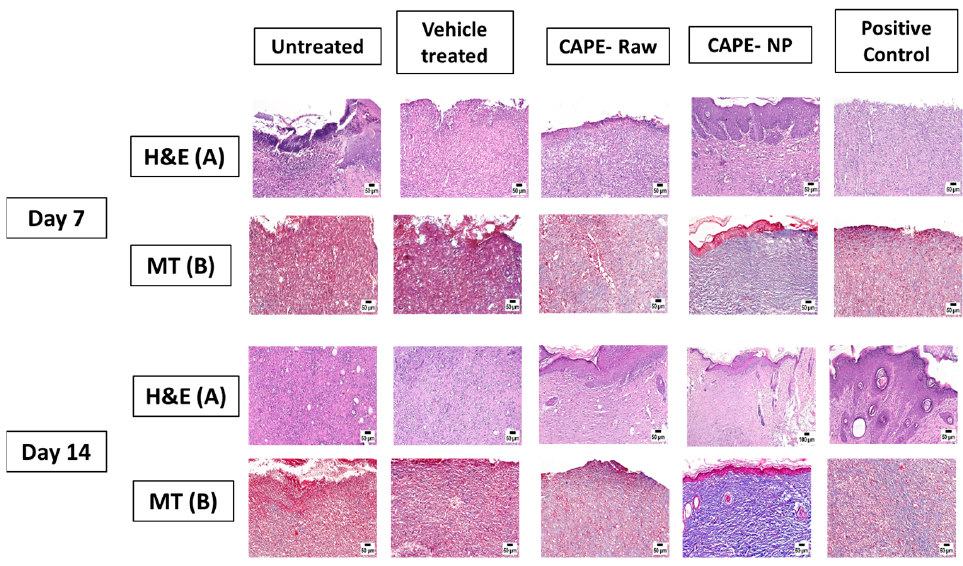
Figure 4. Effects of CAPE-NPs on skin histological changes. (A) H&E staining and (B) MT staining.